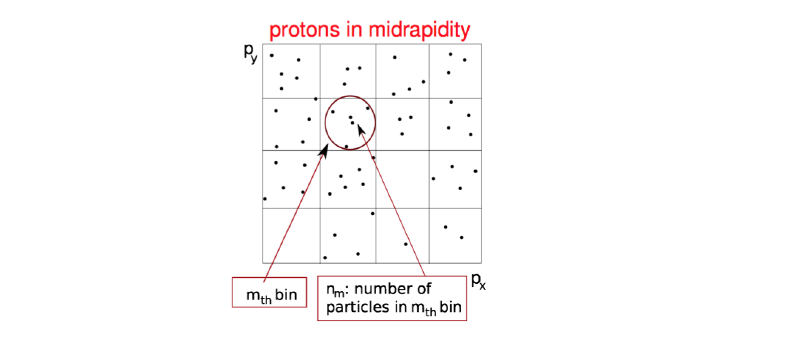
where (cid:104) . . . (cid:105) indicates averaging over events, m is number of a given cell from M cells dividing momentum space. Illustration of the division into M cells is presented in Fig.